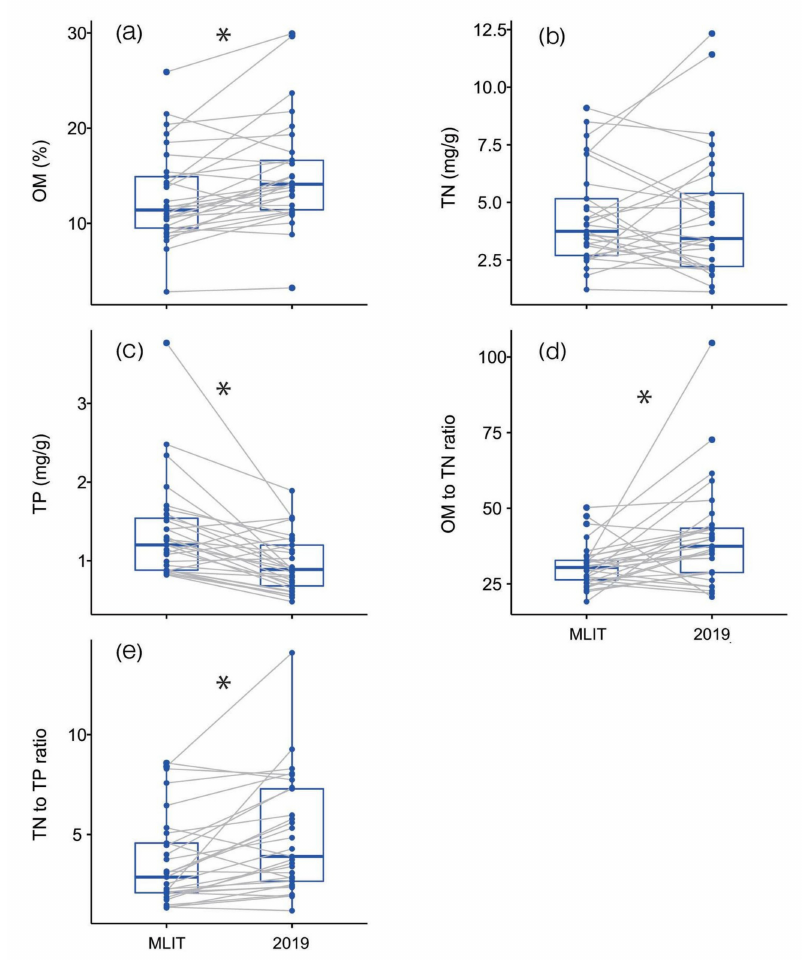
Figure 2. ( a ) OM (%); ( b ) TN (mg/g); ( c ) TP (mg/g); ( d ) OM to TN ration; ( e ) TN to TP ratio; Boxplot showing changes of sediment characteristics between two types of data set. MLIT refers to those collected by the Ministry of land, infrastructure, transport and tourism (MLIT) between 2003–2006 while 2019 was collected in this study in 2019. Data points from the same water bodies were connected by lines for clarity. Asterisks denote statistically significant differences as a result of GLMMs at p < 0.001. Table 2. Results of Generalized Linear Mixed Models (GLMM) testing the effects of data type (data obtained from MLIT or data obtained in 2019) on the sediment characteristics. Statistical significance based on results of Z statistics are shown. Abbreviations: OM is organic matter content (%); TN is total nitrogen (mg/g); TP is total phosphorus (mg/g); AIC is Akaike’s Information Criteria; SE is